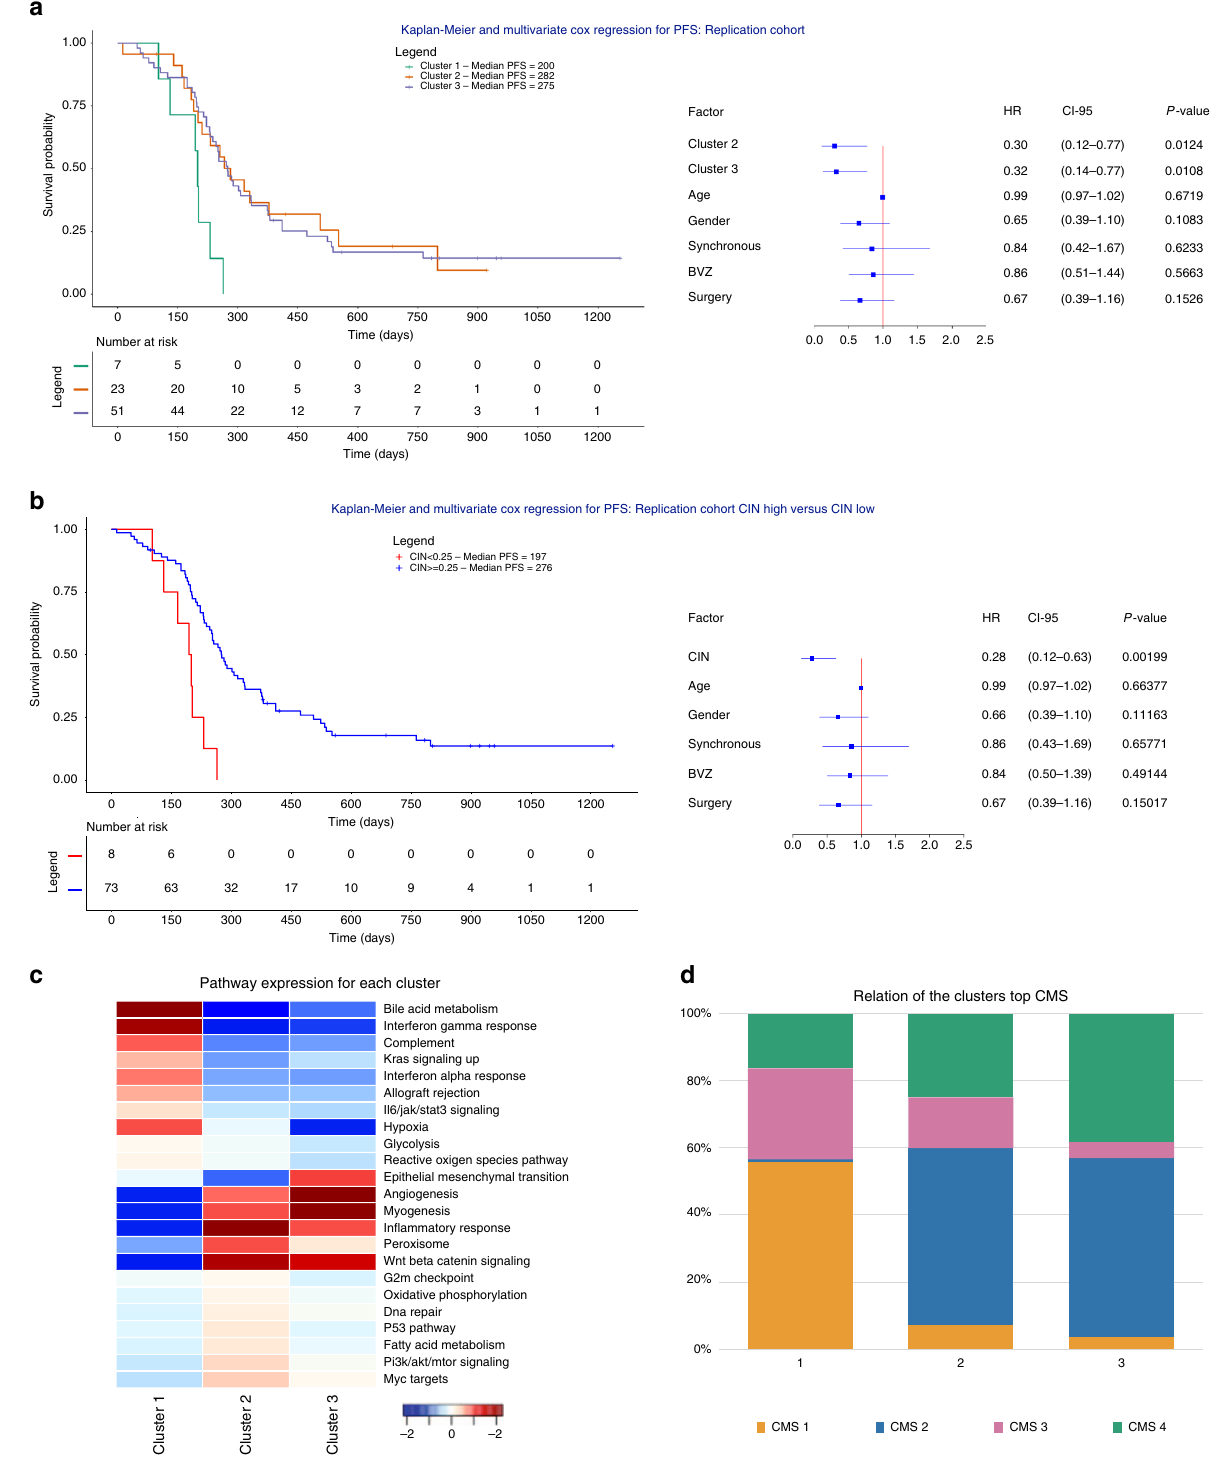
Fig. 7 Replication cohort, pathway expression and overlap with the consensus molecular subtypes. a Application of the random forest classi fi cation model to the replication cohort ( n = 81) classi fi ed the samples in 3 different CNA clusters. Multivariate Cox regression with hazard ratios, 95% con fi dence intervals and P -values are shown for the 3 CNA clusters while correcting for the relevant covariates. Both CNA clusters 2 and 3 were characterized by improved PFS. b Multivariate Cox regression with hazard ratios, 95% con fi dence intervals and P -values are shown for the high CIN versus low CIN tumors while correcting for the relevant covariates. High CIN tumors were characterized by improved PFS. c Heatmap plot showing which pathways were overrepresented in genes differentially expressed in one cluster versus all other clusters. d Overlap between CNA clusters and the CRC molecular subtypes. CMS subtypes could only be established for 362 (out of 499) TCGA tumors for which expression data were available. 82.5% tumors from cluster 1 were CMS1 (55.7%) or CMS3 (26.8%), while 77.4 and 91.4% of cluster 2 or 3 tumors respectively, were CMS2 (52.6 and 53.1%) or CMS4 (24.8 and